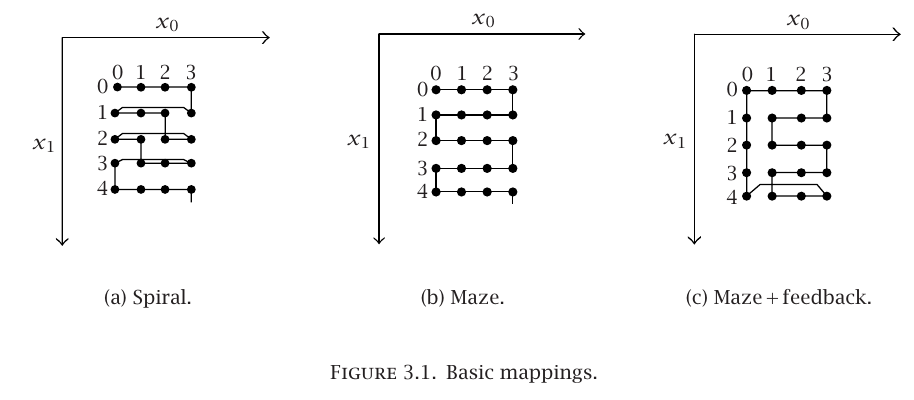
Spiral mapping. Figure 3.1(a) is the graphical view of this mapping. The cycle